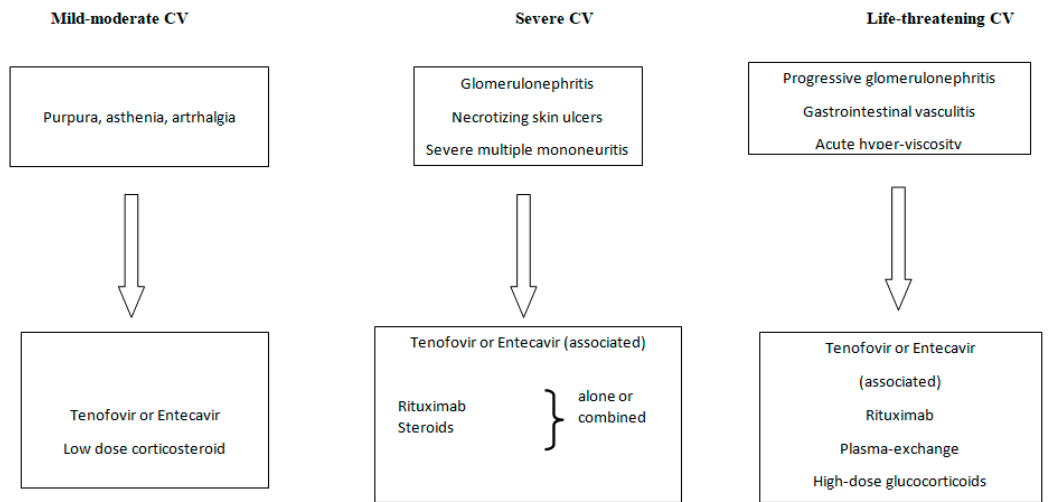
Figure 1. Flow-chart of HBV- related cryoglobulinemia vasculitis therapeutic management.